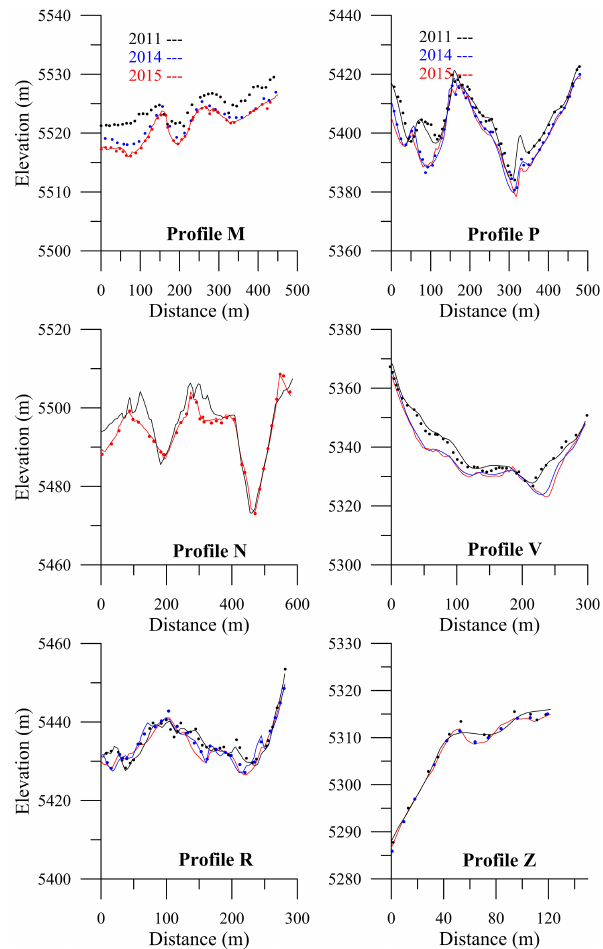
Figure 5. Surface elevation profiles (ma.s.l.) for 2011 (black), 2014 (blue) and 2015 (red) from DGPS measurements (dots), terrestrial photogrammetry (black and blue lines) and UAV survey (red lines). Note that the right (left) bank is on the left (right) of each